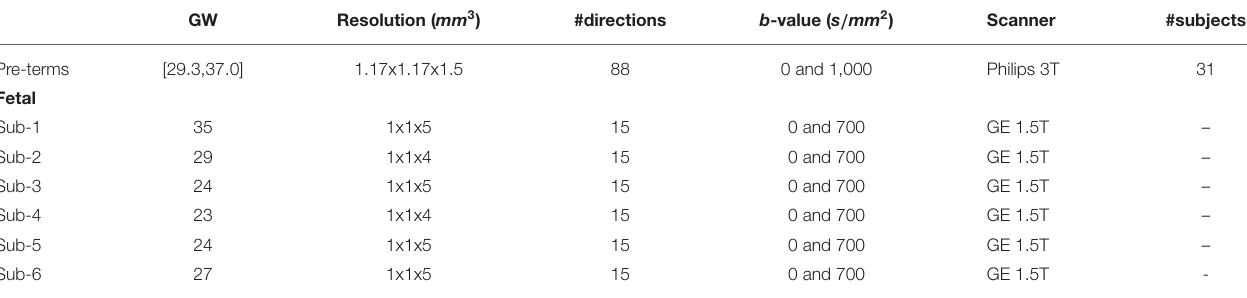
TABLE 1 | Pre-term newborns and fetal attributes of the processed data that were used in our experiments.